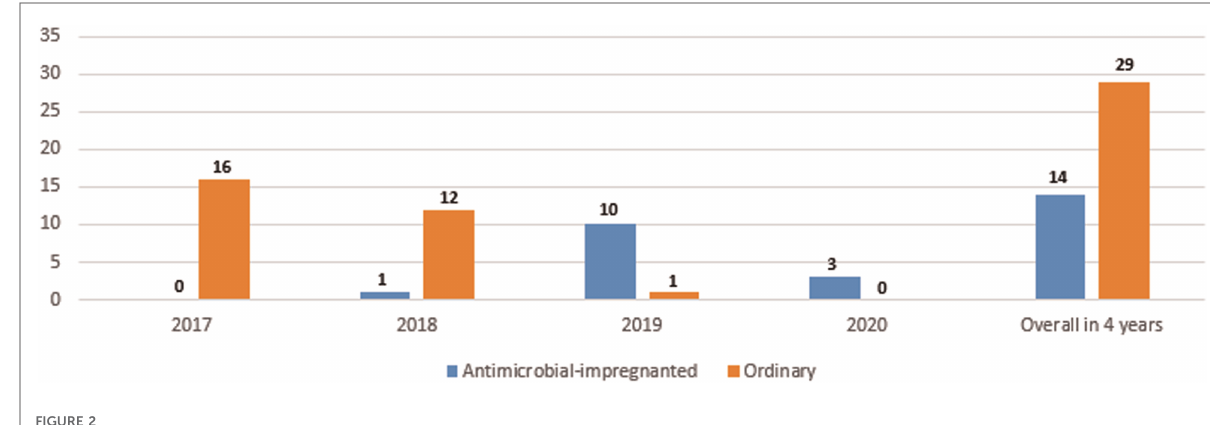
FIGURE 2 Number of CLABSI cases between the two types of catheters across the 4 years.